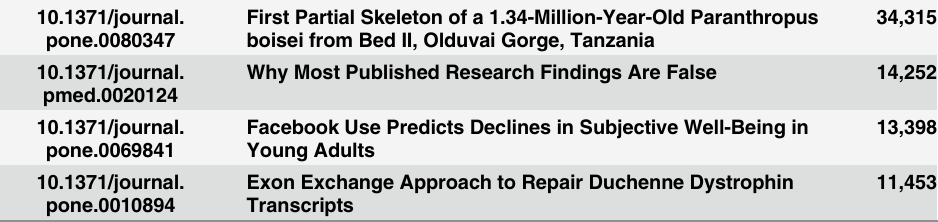
Table 1. PLOS page view increases. Dec 10, 2013 to Jan 10, 2014.